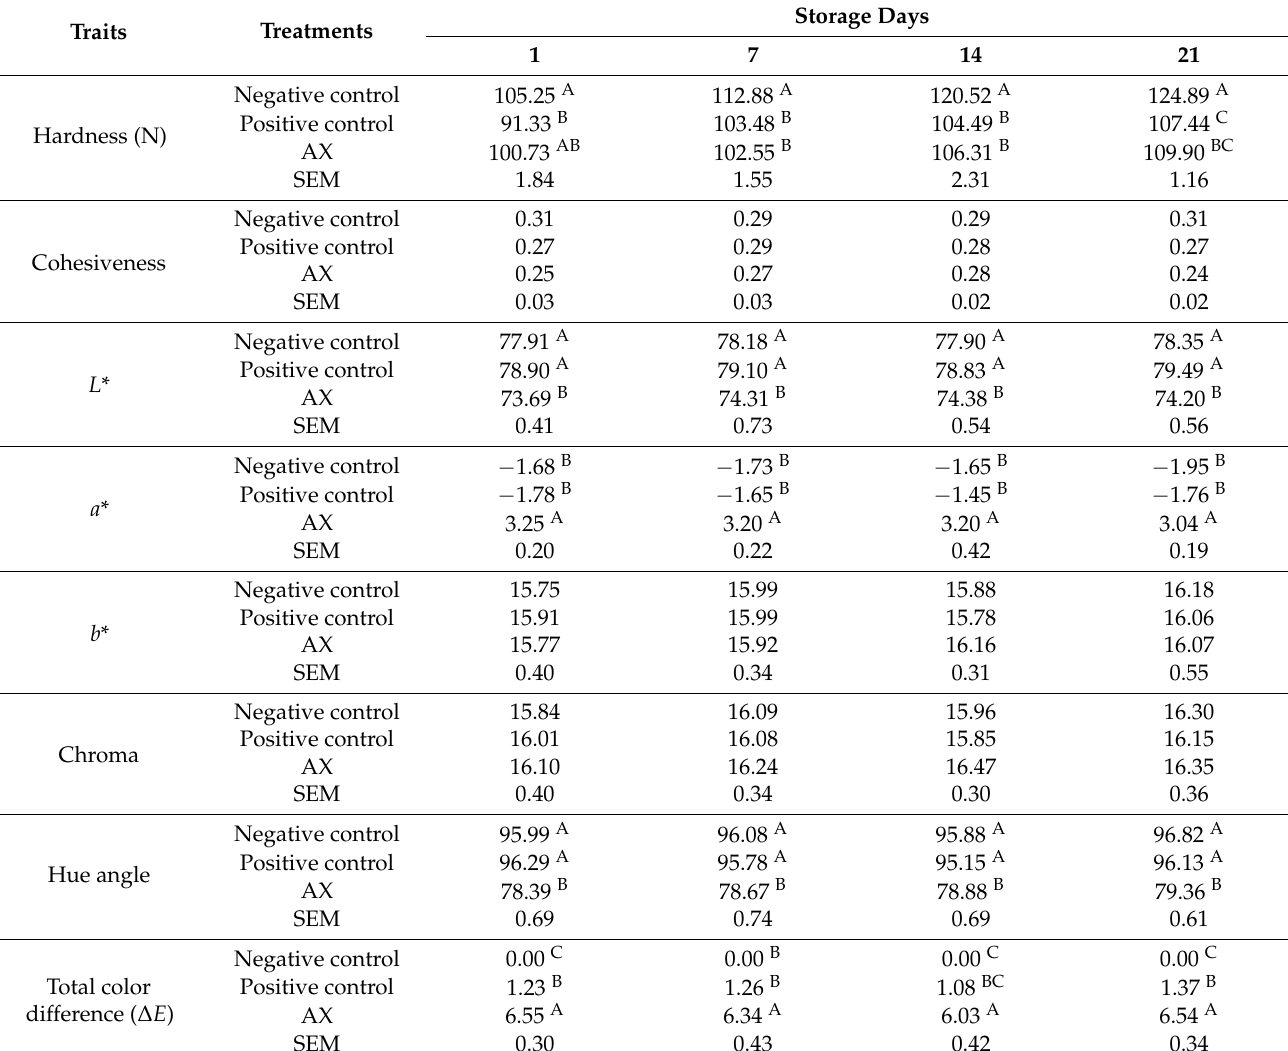
Table 2. Textural properties and instrumental color evaluation during cold storage of emulsified sausages with different